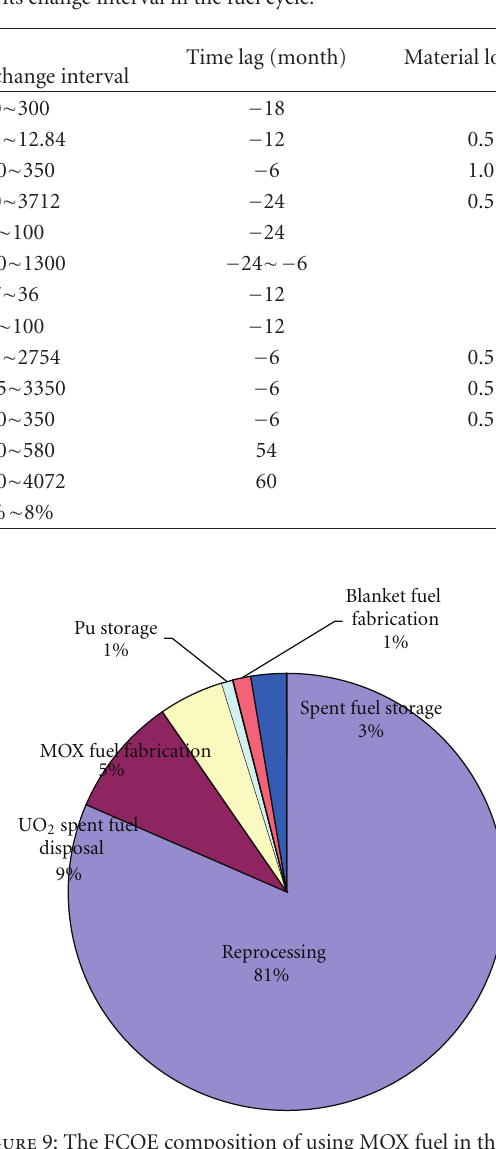
Table 4: The price of processing techniques and its change interval in the fuel cycle.